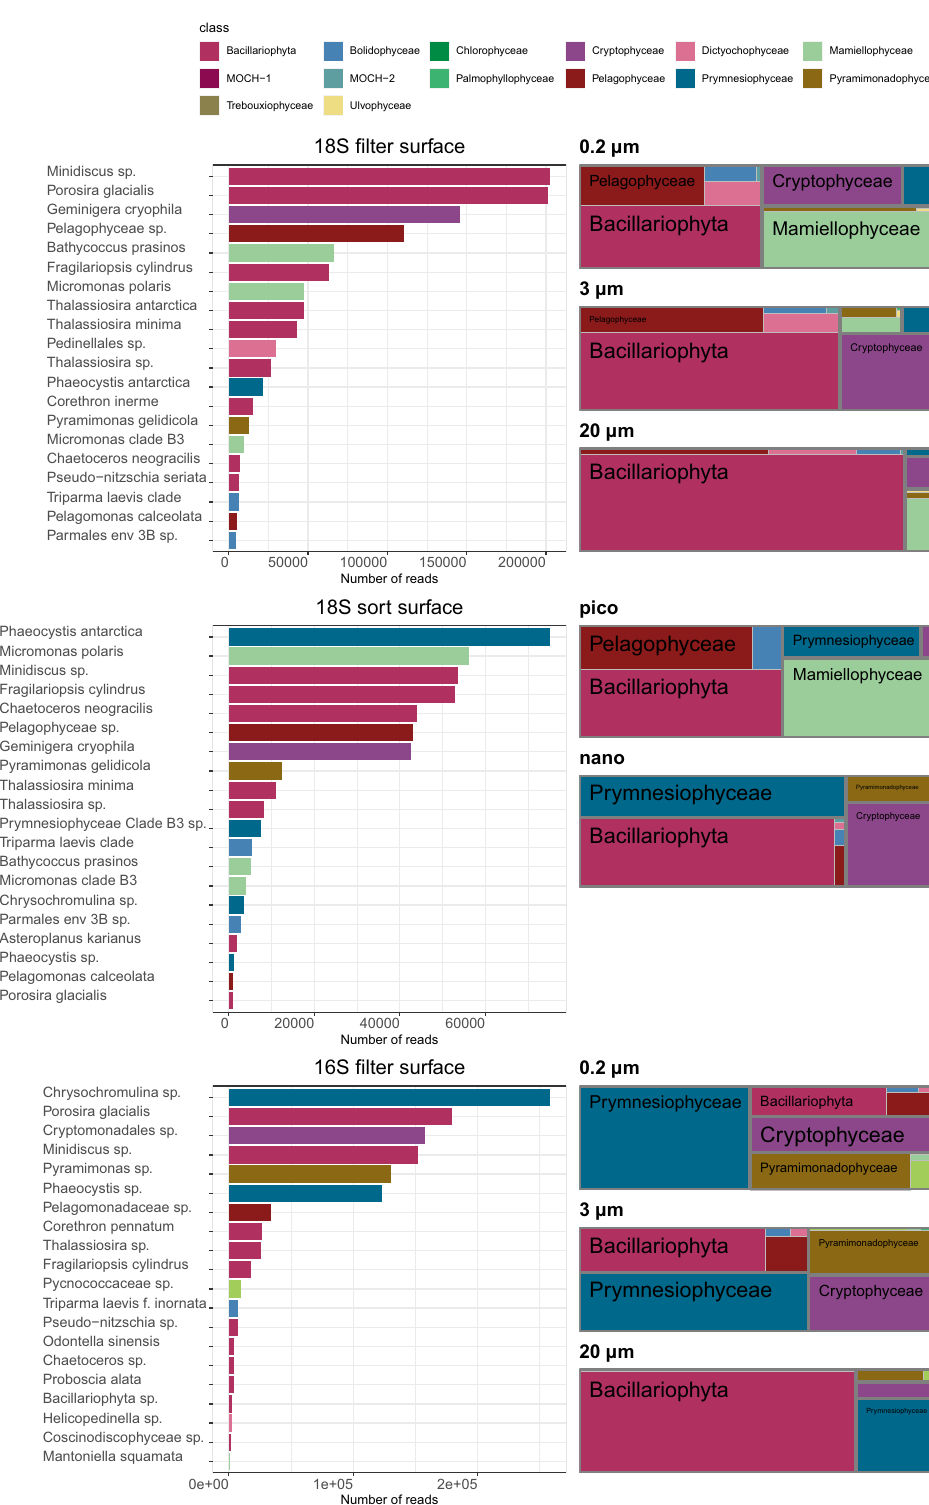
Figure 2. Community composition of phytoplankton (excluding dinoflagellates) at species level for surface samples (5 m) at station 6 in Fildes Bay. Top panel: 18S rRNA gene for filtered samples. Middle panel: 18S rRNA gene for sorted samples. Bottom panel: plastidial 16S rRNA gene for filtered samples. Left side: abundance rank chart for major species. Right side: proportional area charts of relative abundance of classes by size fraction. 0.2, 3, and 20 µ m correspond to the 0.2–3, 3–20 and > 20 µ m size fractions,